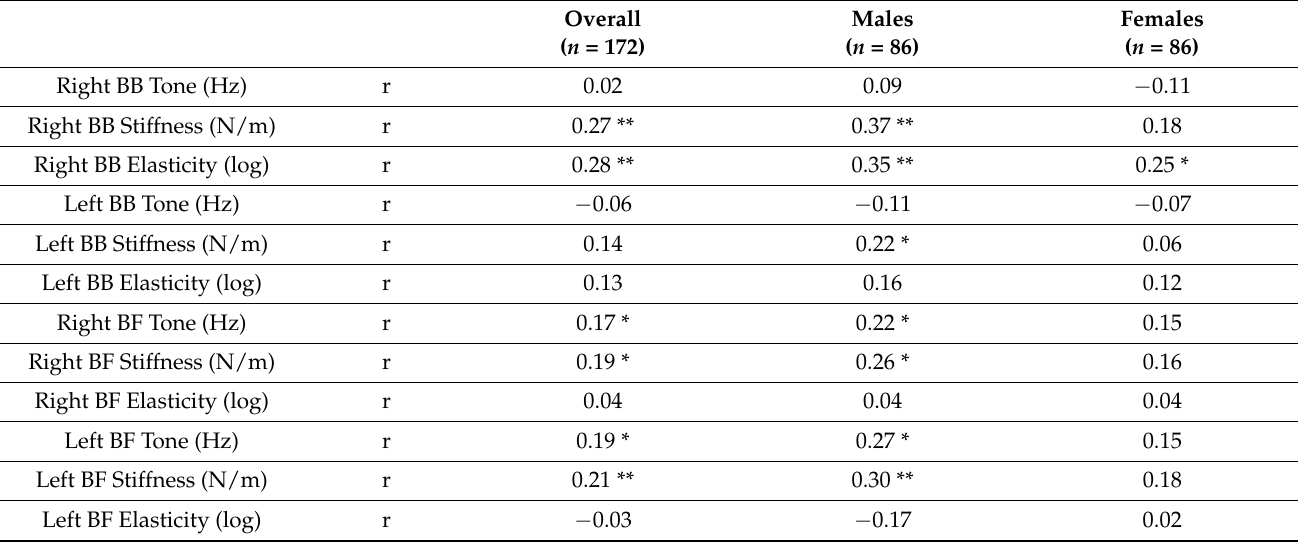
Table 3. Correlations between the viscoelastic properties of BMI and the BB and BF muscles.